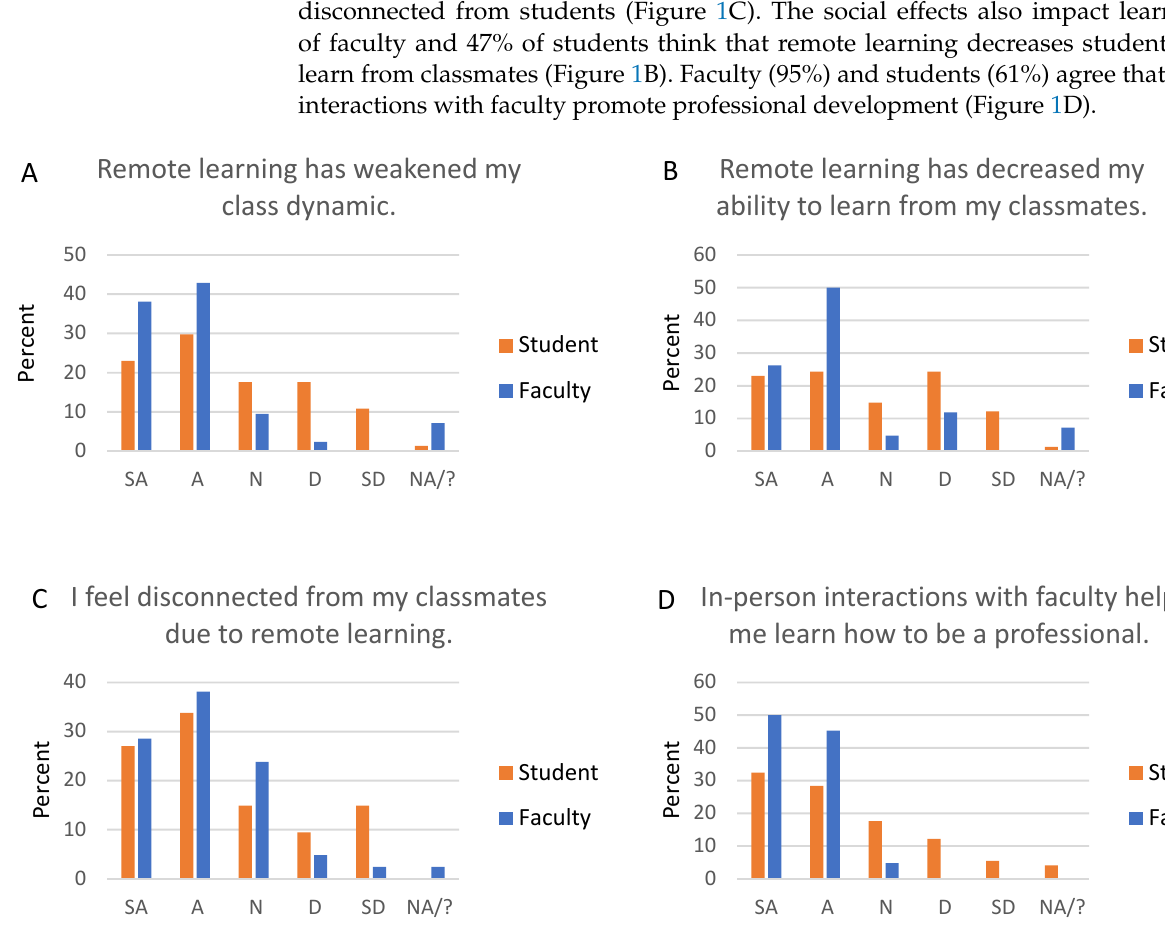
Figure 1. Social impacts of remote learning. All students and faculty were asked about the social impacts of remote learning. Graph titles reflect wording asked of students, but wording was customized for students and faculty. For example, the statement for students was “Remote learning has weakened my class dynamic”, and the statement for faculty was “Remote learning has weakened dental student class dynamics”. SA, strongly agree; A, agree; N, neutral; D, disagree; SD, strongly disagree; NA/?, not applicable/don’t know.